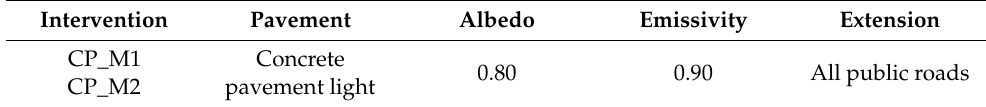
Table 7. Settings for the road pavement in the case of the cool pavement adoption (CP). Intervention